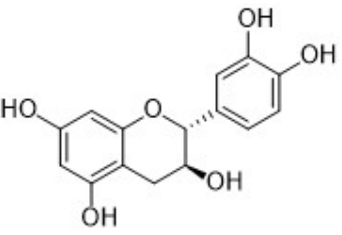
Figure 24. Chemical structure of catechin (CAT).